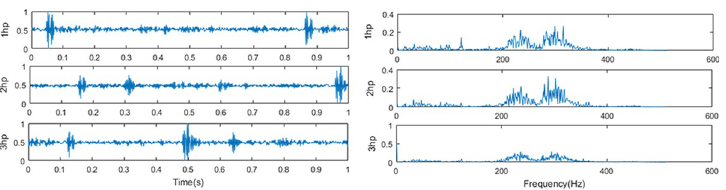
Fig 10. The diagnostic signal with an inner race fault size of 0.014 inches under different loads. (a) the time- domain waveform and (b) the corresponding frequency spectra.